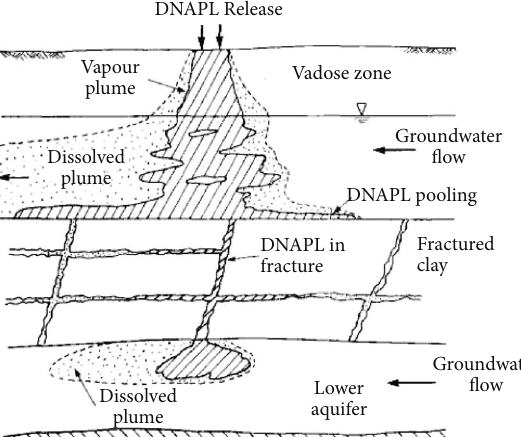
Figure 1: Migration and di ff usion process of DNAPL in underground environment [11].